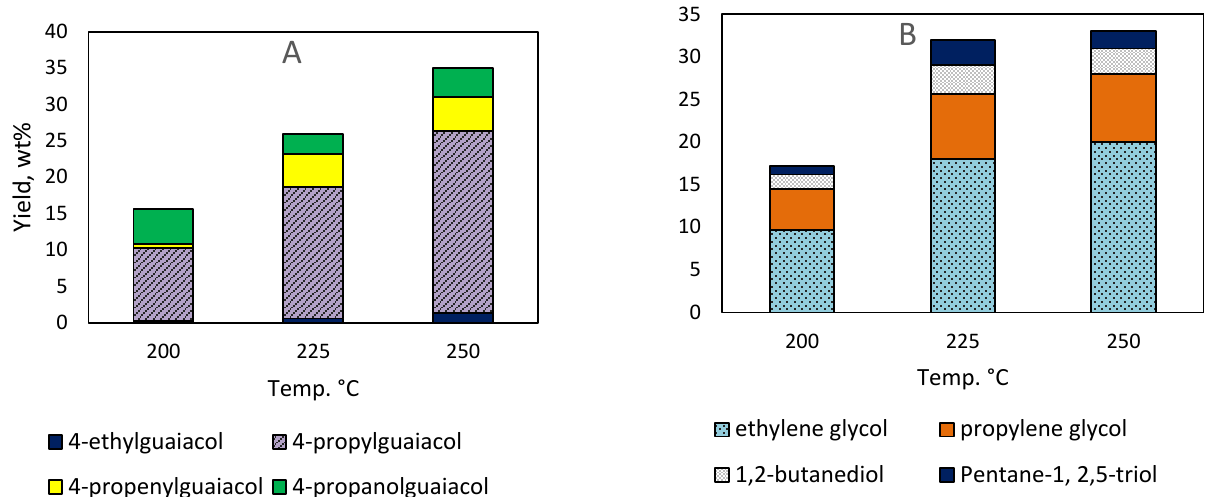
Figure 8. The effect of temperature of spruce wood RCF over the 3RS450 catalyst on the yield of phenolic monomers ( A ) and polyols ( B ).